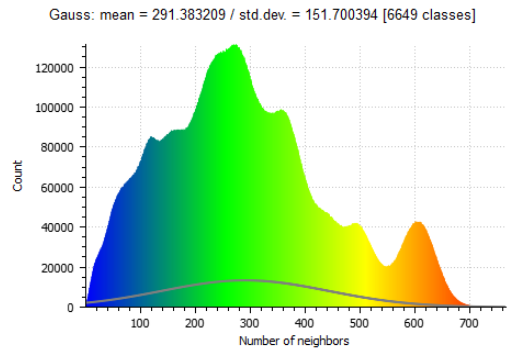
Figure 16. Density analysis histogram of the F6 SR point cloud